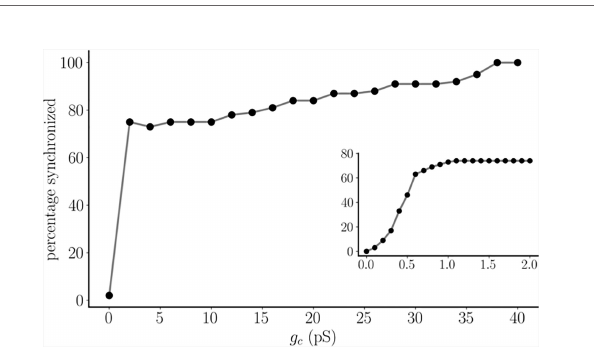
FIGURE 3 | The percentage of synchronized pseudo-plateau bursting oscillations for a pair of identical model pituitary cells. For each coupling strength, g c , simulations are run for 100 randomly-determined initial conditions. This same set is used for each value of g c . For the main graph, the coupling strength step size is 2 pS, but a smaller step size of 0.1 pS is used for the inset. Note that units of pS are used in the fi gure.